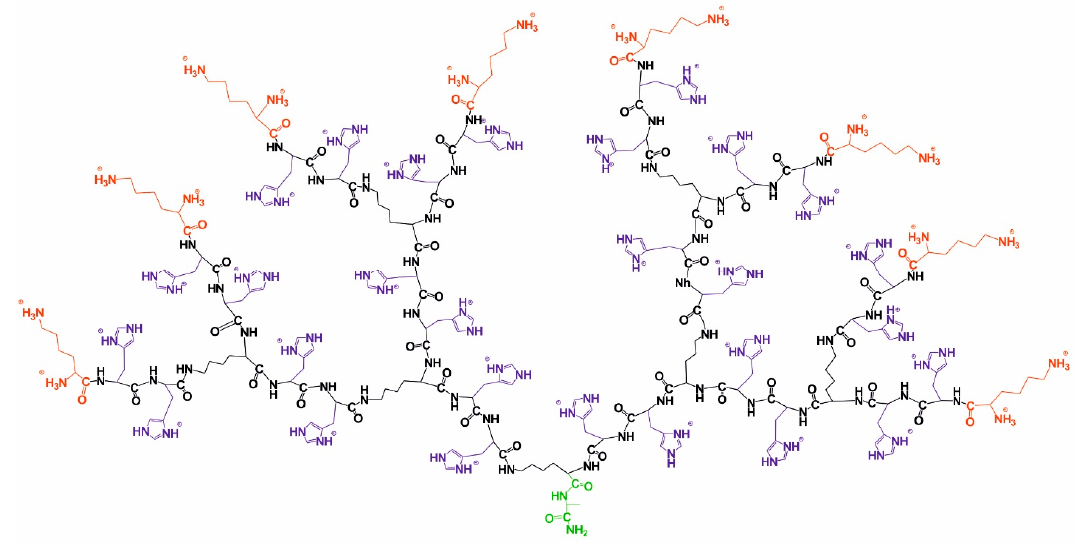
Figure 1. Structural formula of Lis-2His dendrimer. Green color marks the core, black corresponds to the main chain, violet marks the side segments, and red corresponds to the terminal segments.